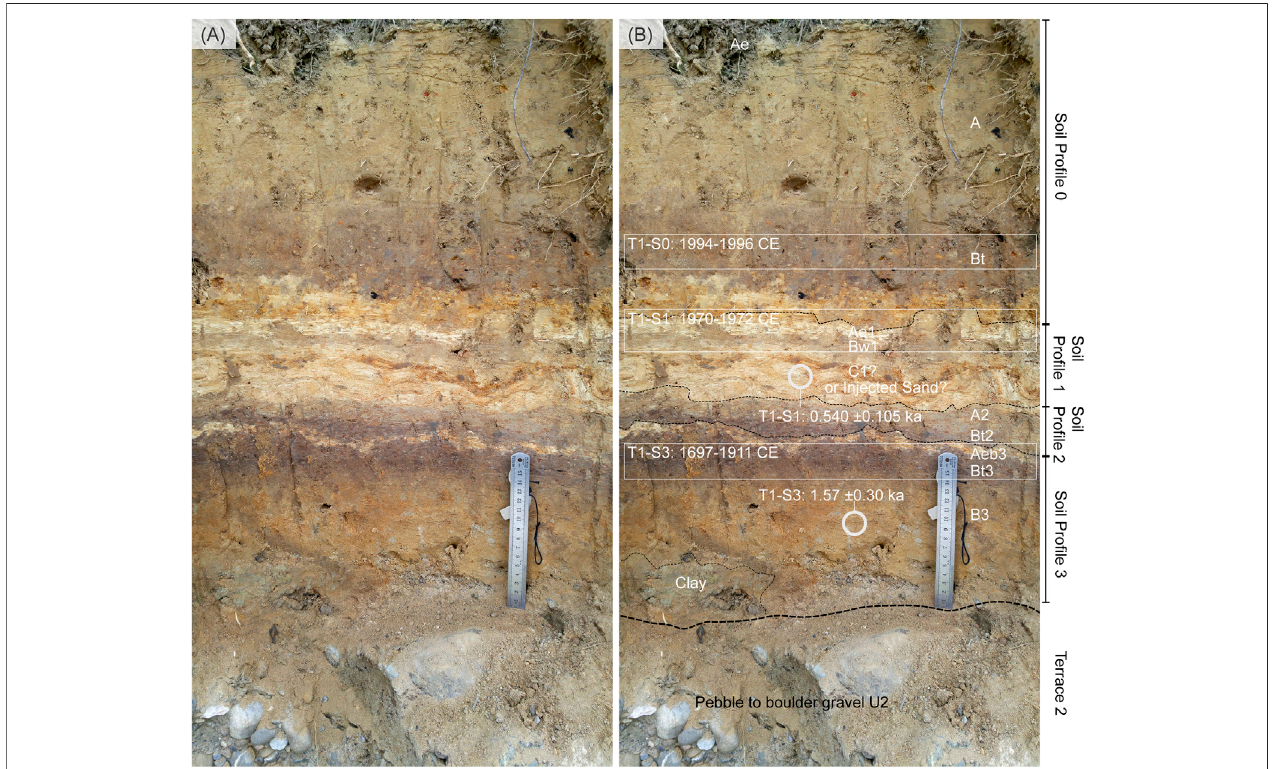
FIGURE6| Terrace1atthesouthernendofthepalaeoseismicexposure( Figure4 ). (A) originalphotograph, (B) interpretedphotograph.Terrace1isinterpretedas a cut-in- fi ll terrace on top of layer U2 of Terrace 2. Material for radiocarbon dating was collected along horizons indicated with white rectangles. The deposits of T1 are interpreted as overbank deposits being converted to modern soil. The injected sand layer was interpreted based on the age distribution and photograph analysis (see main text for alternative interpretations).